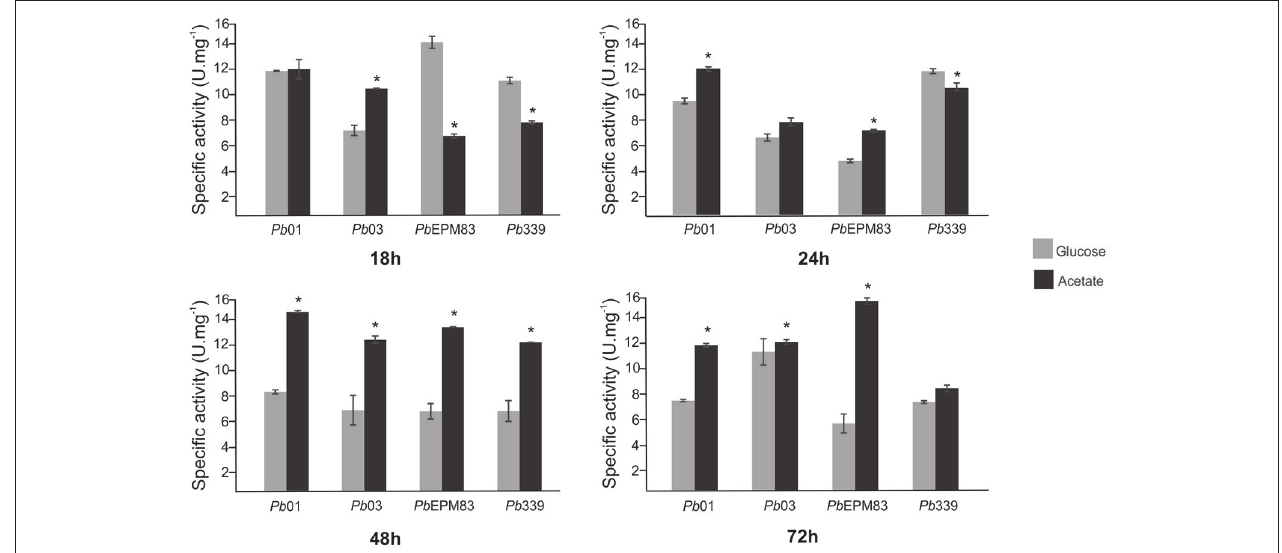
FIGURE 1 | Isocitrate lyase (ICL) activity assay. Activity was determined by measuring the formation of glyoxylate as its phenylhydrazone derivative under each condition. A total of 50mg of each total protein extract of Paracoccidioides isolates Pb 01, Pb 03, Pb 339, and Pb EPM83 yeast cells were cultivated in minimal media with sodium acetate (100mM) and glucose (100mM) for different times (18, 24, 48, and 72h). The specific activity of ICL was determined as the amount of enzyme required to form 1 µ mol of glyoxylate-phenylhydrazone per minute, per mg of total protein, and represented as U · mg − 1 . Errors bars represent standard deviation from three biological replicates while * represents p ≤